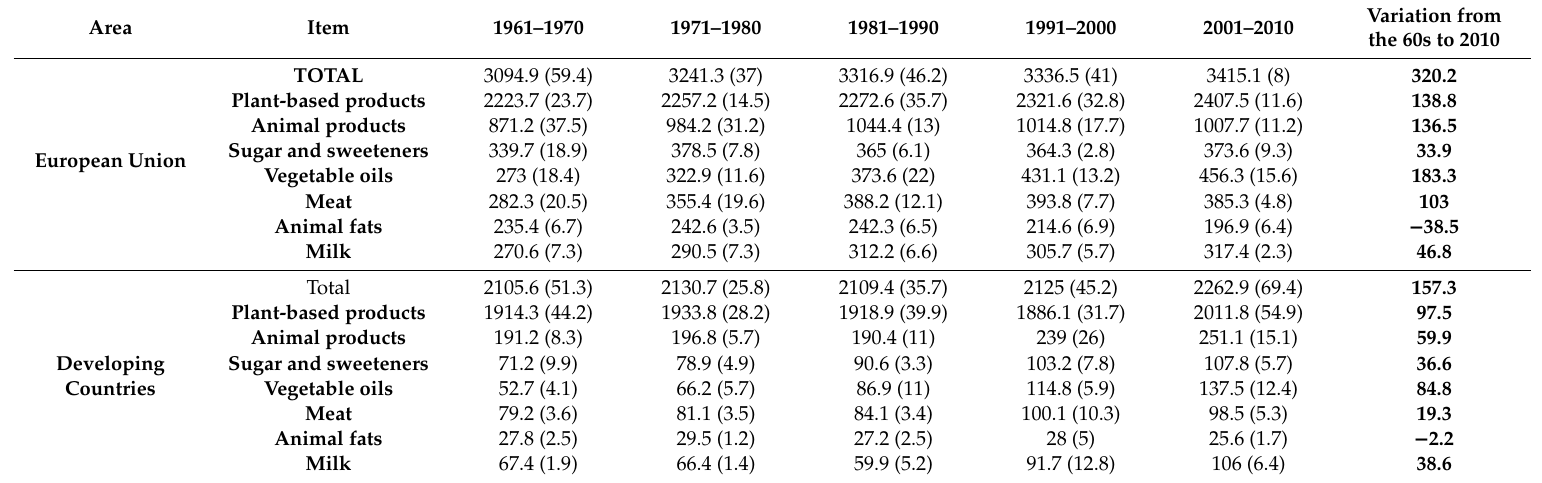
Table 1. Energy intakes in the last five decades (kcal / capita /